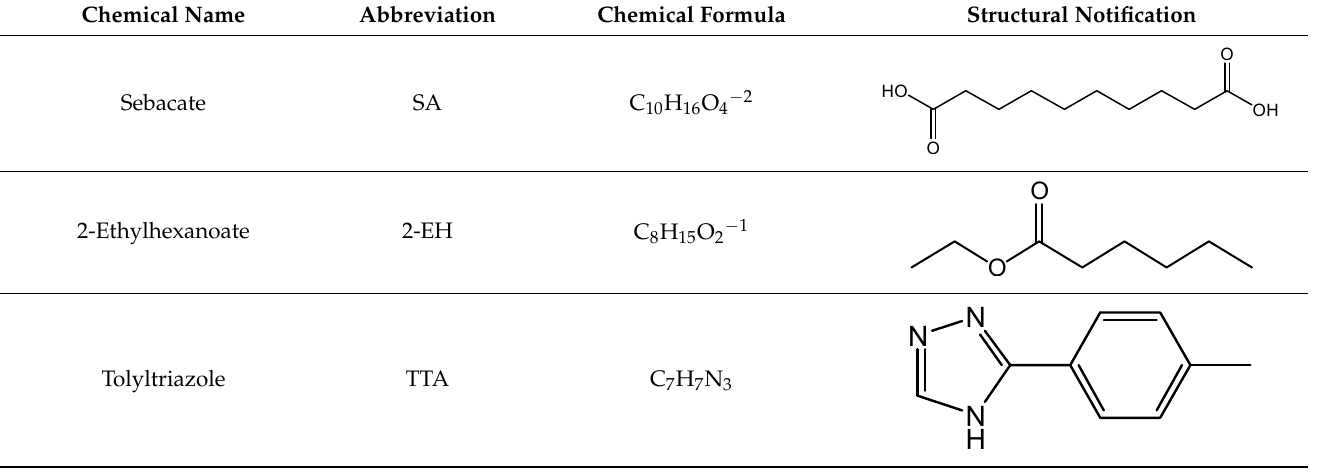
Table 2. List of inhibitor additives in the engine coolants used in this study.